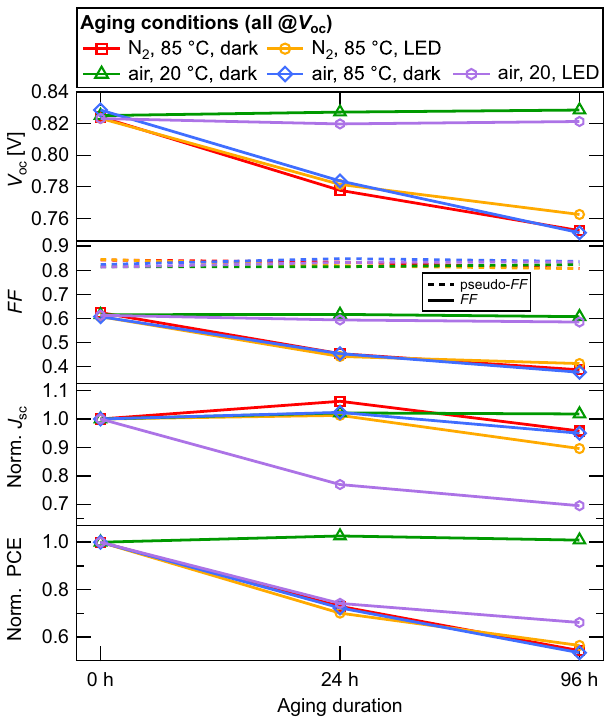
Fig. 1 Solar cell parameters of devices aged under various conditions. Samples aged in air at room temperature in the dark maintain their power conversion ef fi ciency (PCE) over the whole aging duration of 96 h studied here. Degradation in air at room temperature under illumination is governed by losses of J sc . Aging at elevated temperatures in air in the dark as well as in a nitrogen atmosphere regardless of illumination all show losses of V oc and FF. The pFF is stable for all aging conditions studied